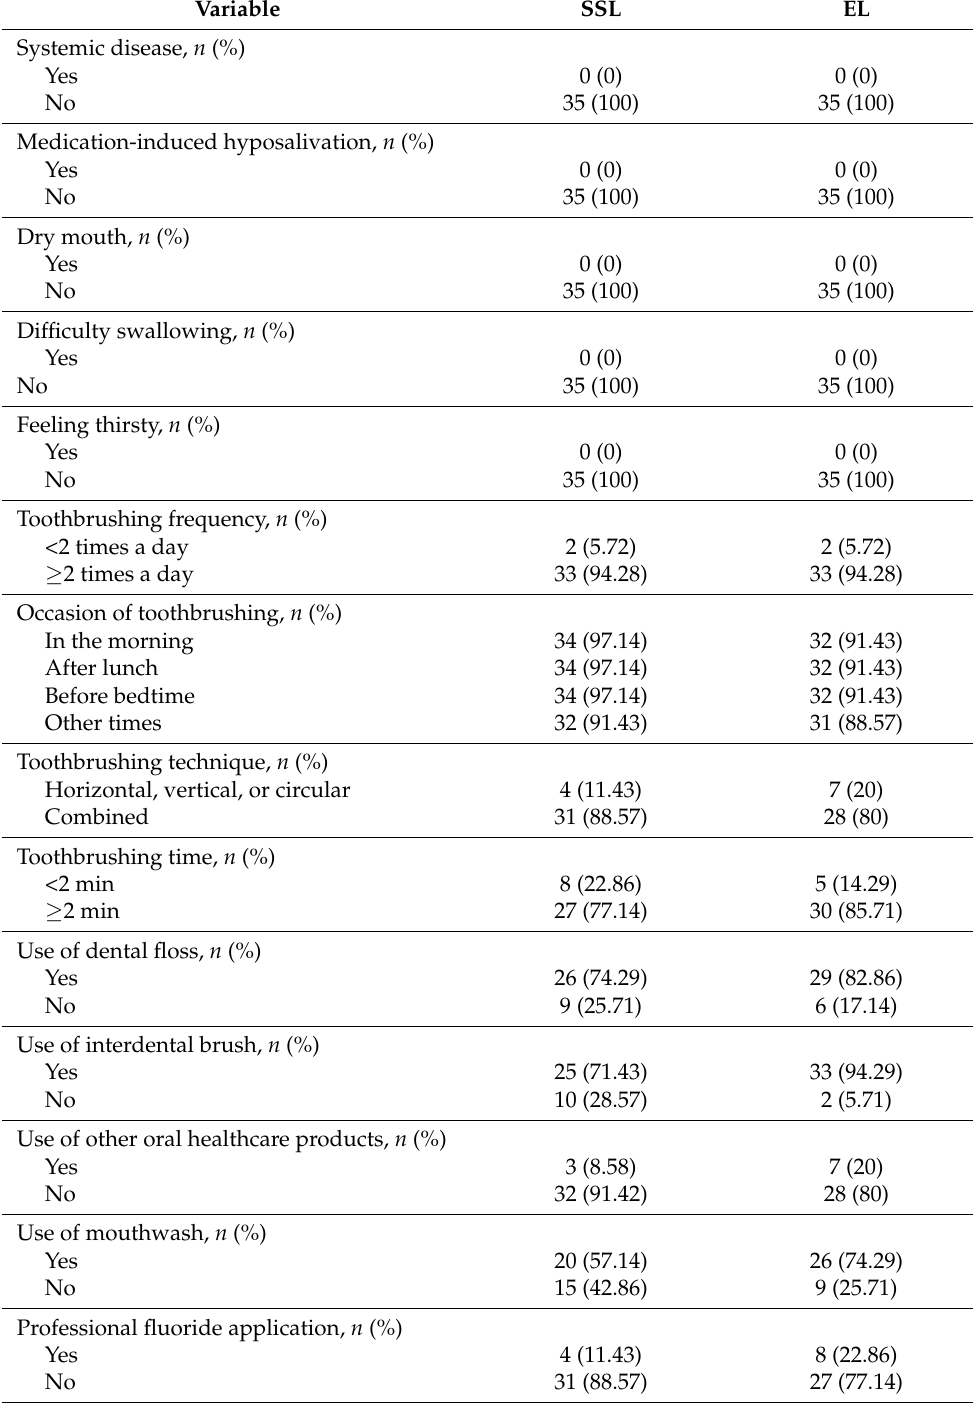
Table 2. Distribution of the patients’ medical history and dental health behaviors based on ligature type at